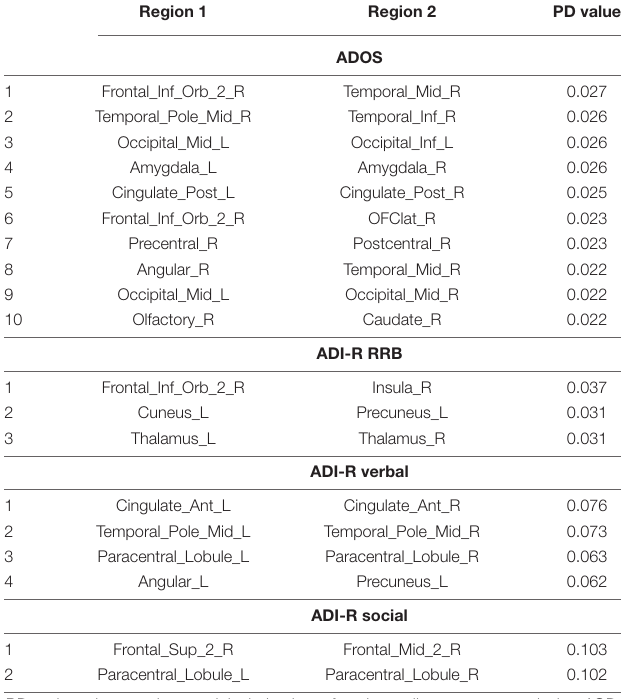
TABLE 1 | Most predictive connections for the severity of ASD based on ADOS and